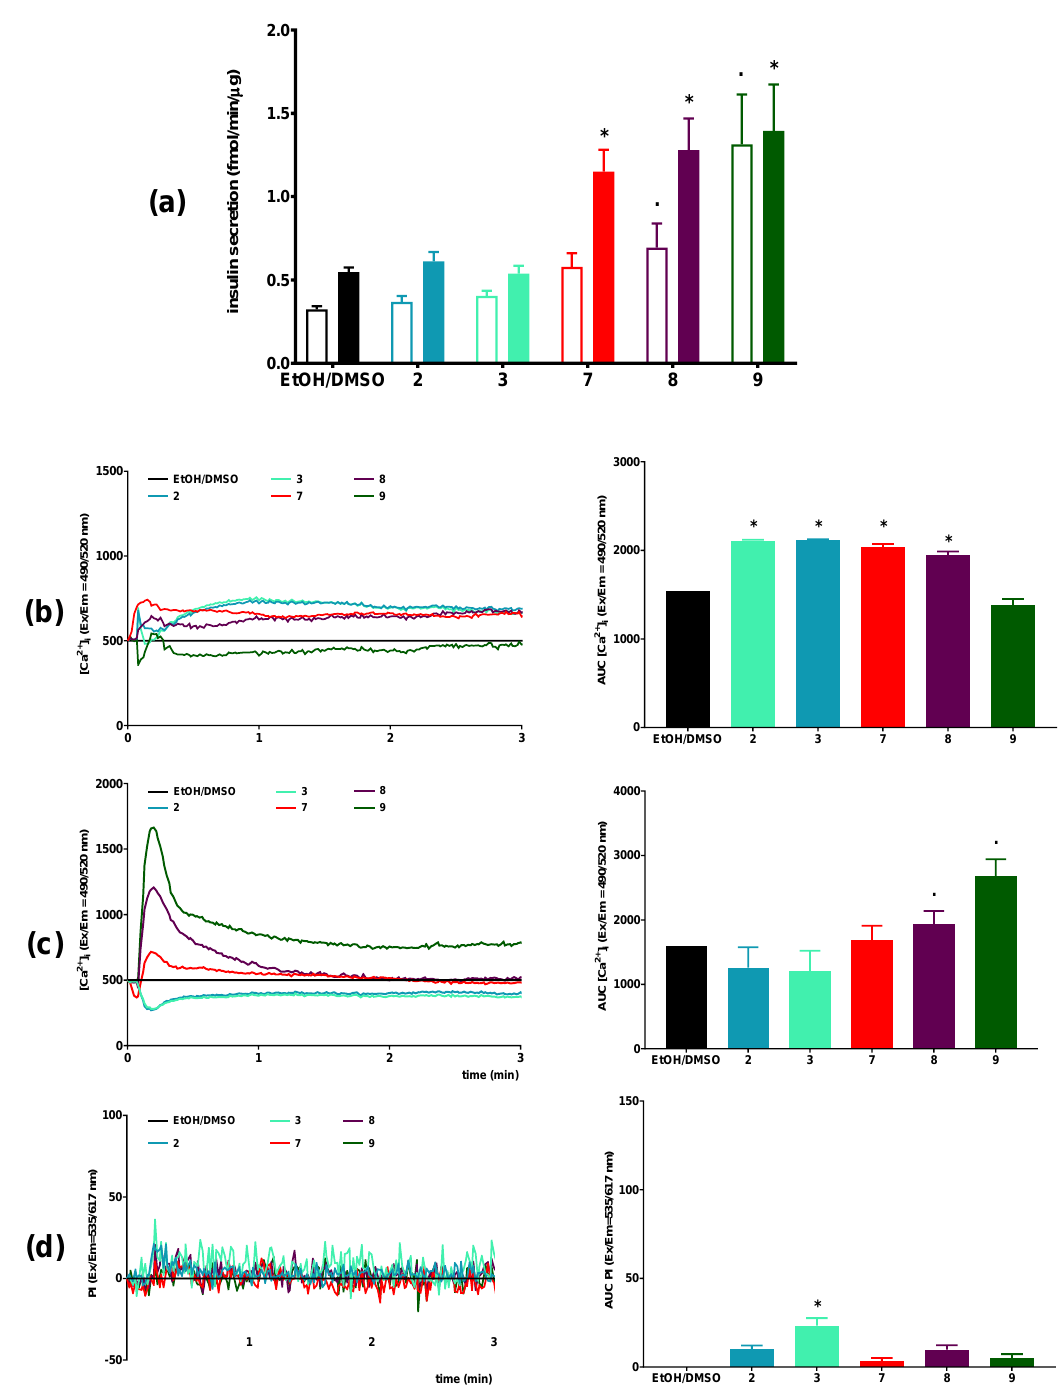
Figure 6. Influence of 3-methoxybenzoic acid (2), veratric acid (3), and LPCs (7–9) at 50 µ M concentration on MIN6 cells versus compound solvent control (EtOH / DMSO) in terms of GSIS ( a ) and [Ca 2 + ] i mobilization at 20 mM ( b ) and 2 mM ( c ) glucose conditions with simultaneous monitoring of membrane integrity ((d) presented for 20 mM glucose conditions). For GSIS ( a ), results are presented for insulin secreted at 2 mM glucose conditions (open bars) and 20 mM glucose conditions (closed bars). For [Ca 2 + ] i mobilization ( b , c ) and membrane integrity ( d ), the results are presented as the real-time kinetics of [Ca 2 + ] i and [PI] changes inside the cell during 3-min monitoring as well as AUC. p < 0.05 for secretion, AUC [Ca 2 + ] I , or AUC PI significantly di ff erent from 2 mM glucose control (.) and 20 mM glucose control (*).